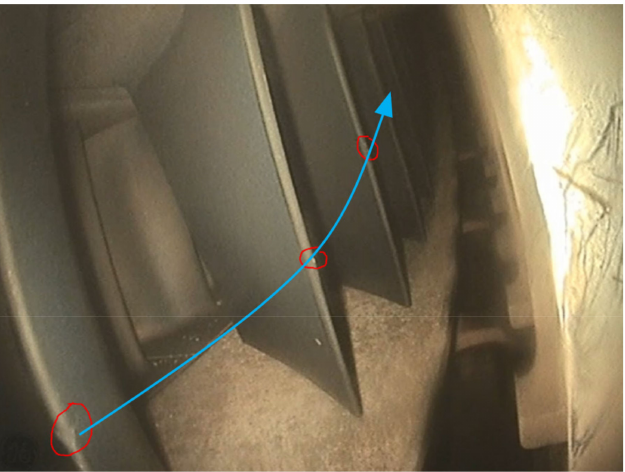
Figure 25. Inspection results of a borescope inspector (red circles) and foreign object trajectory (indicated blue